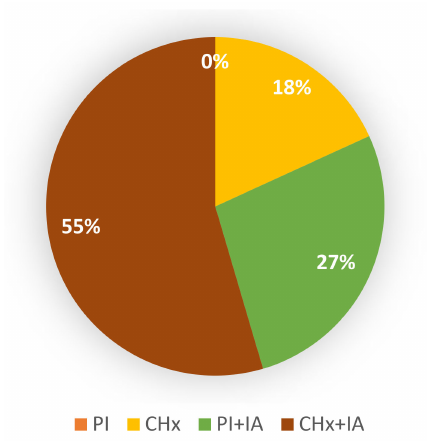
Figure 4. Graphical representation of the fraction of cases in which each protocol obtained the lowest bacterial load within the hooves of the same animal. PI: two consecutive 3 min scrubs with Povidone- iodine (PI); Chlorhexidine (CHx): two consecutive 3 min scrubs with CHx; PI + Iron Animals (IA) and CHx + IA represent PI and CHx protocol followed by the application of 10 mL of IA for 15